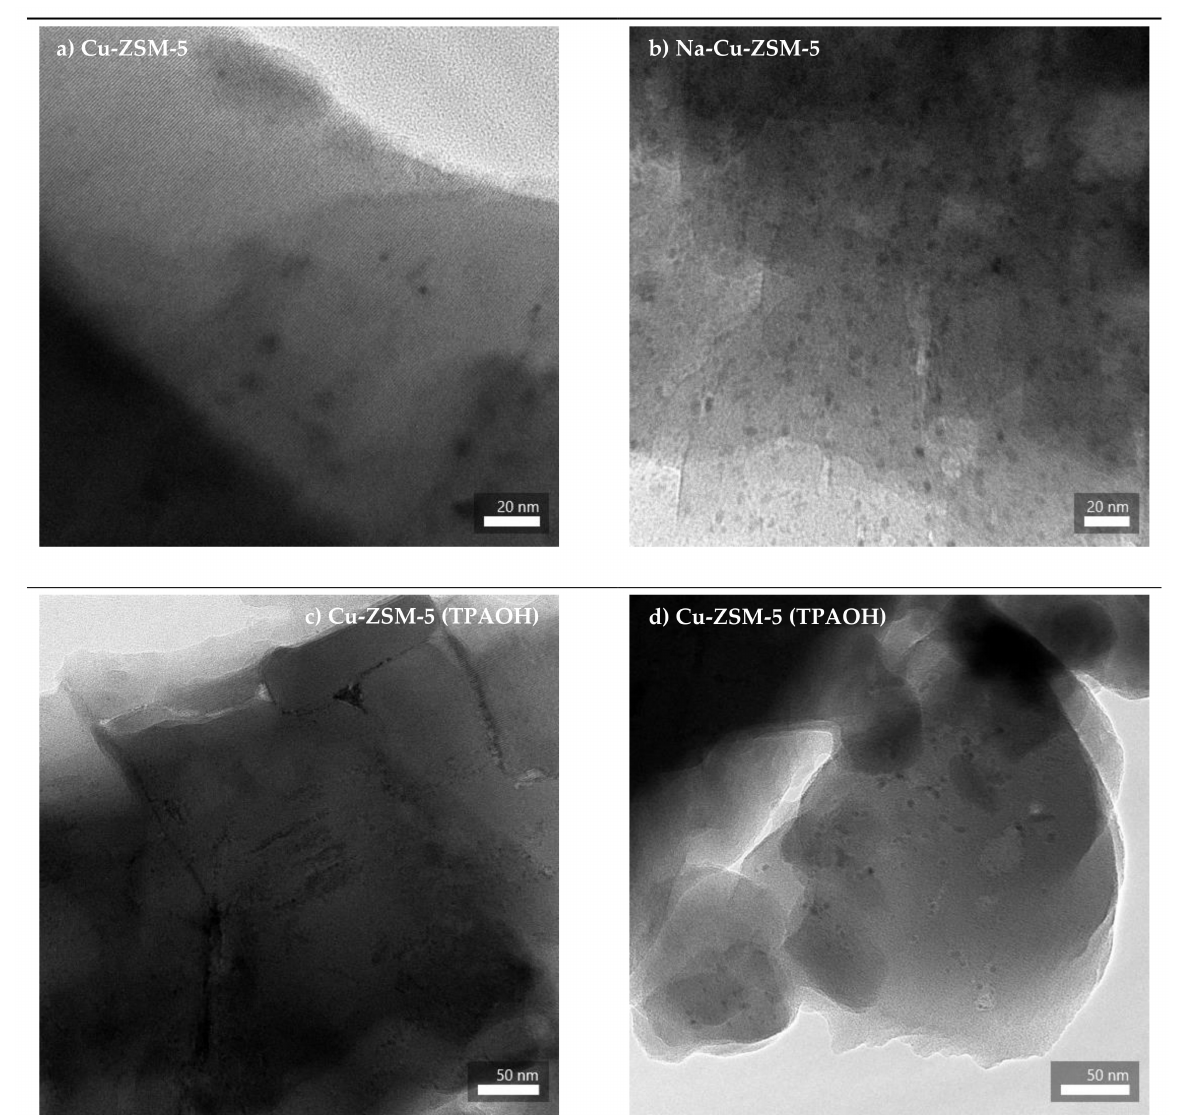
Figure 2. TEM images of selected Cu-exchanged ZSM-5, ( a ) Cu-ZSM-5, ( b ) Na-Cu-ZSM-5, ( c , d ) Cu-ZSM-5